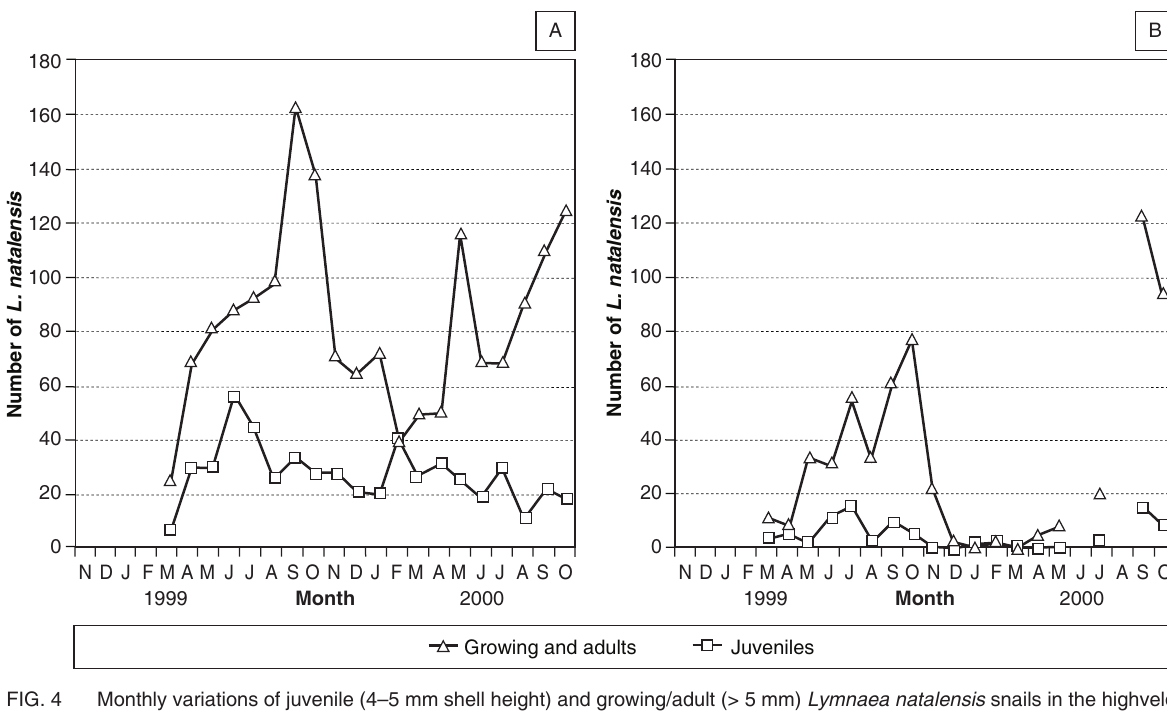
TABLE 6 Recovery of Lymnaea natalensis according to habitat from seven districts in the highveld and lowveld communal grazing areas of Zimbabwe for the period November 1998 – October 2000